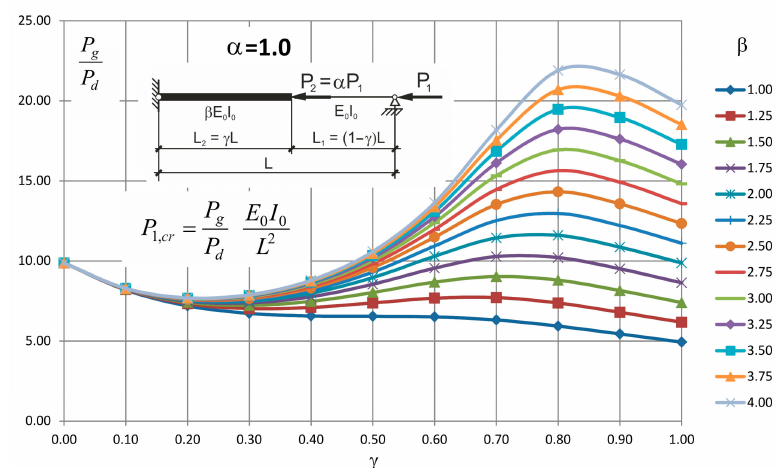
Figure 7. Values P g /P d for α = 1.0 and for different values of β and γ .